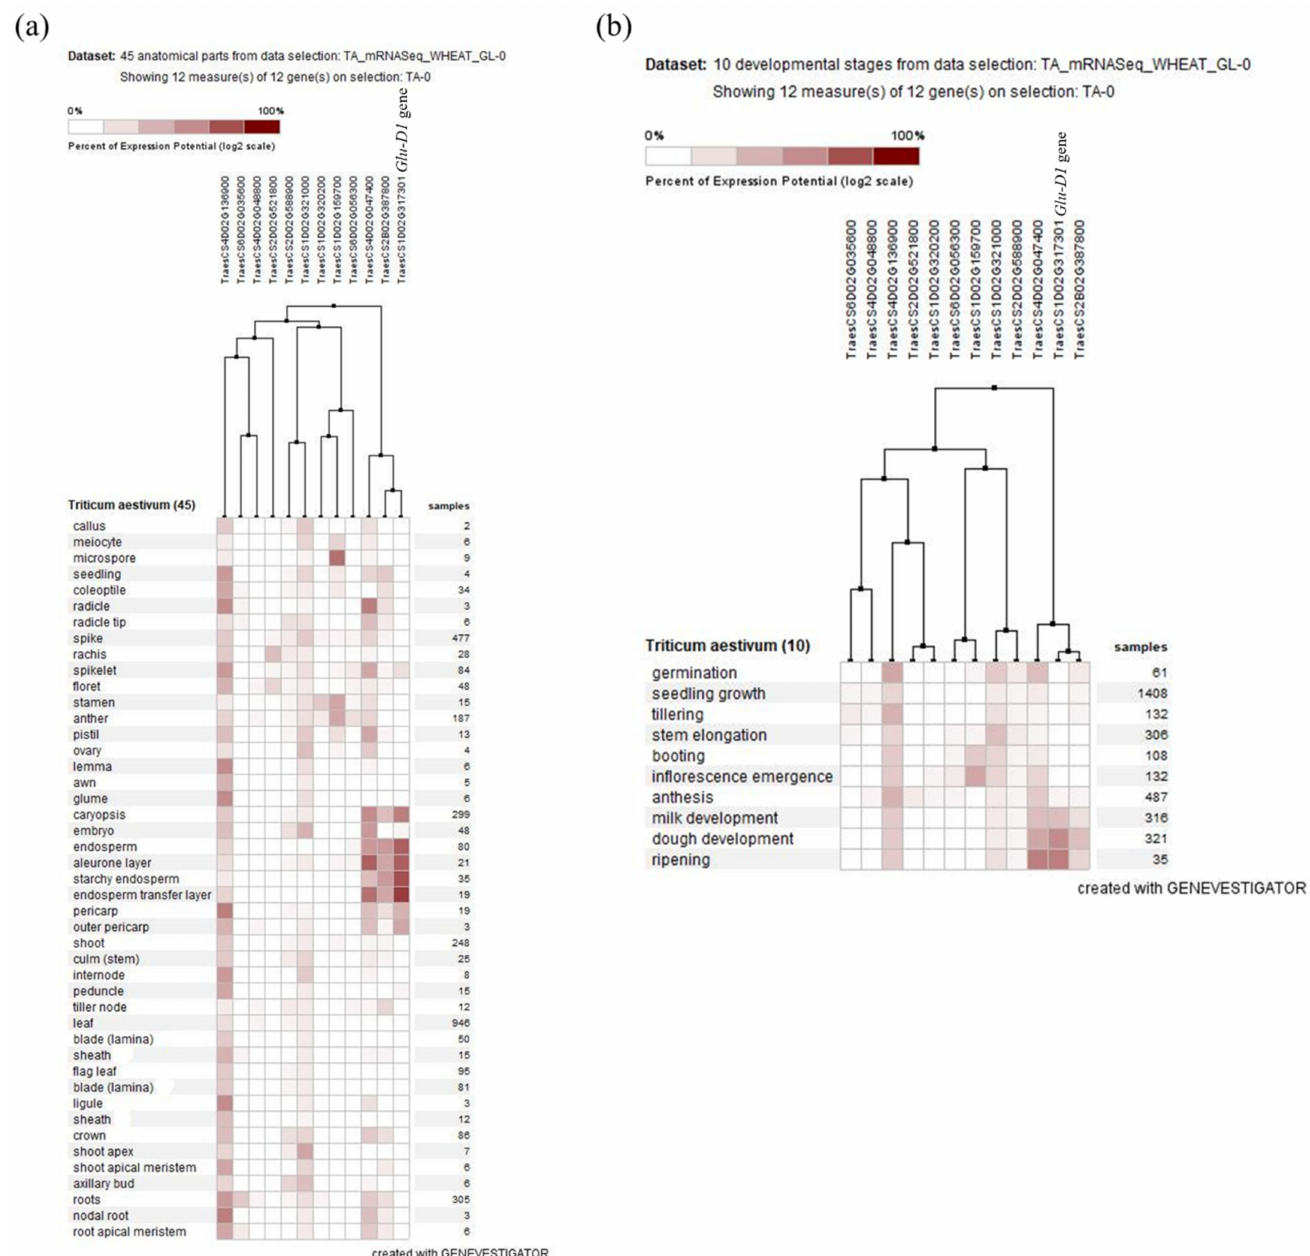
Figure 8. The expression of the candidate genes compared to the Glu-D1 gene expression ( TraesCS1D02G317301 ) in different anatomical parts ( a ) and at different developmental stages ( b